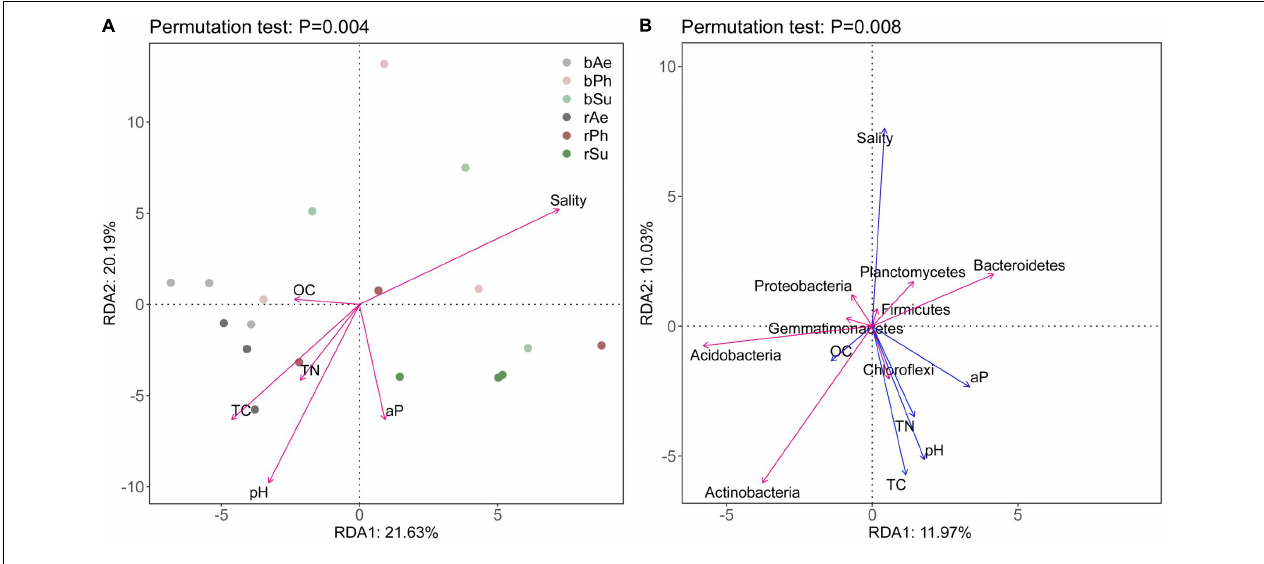
FIGURE 9 | RDA of environmental factors and bacterial communities in rhizosphere and bulk soils of different halophytes: (A) correlation between soil physicochemical properties and bacterial community and (B) correlation between soil physicochemical properties and dominant